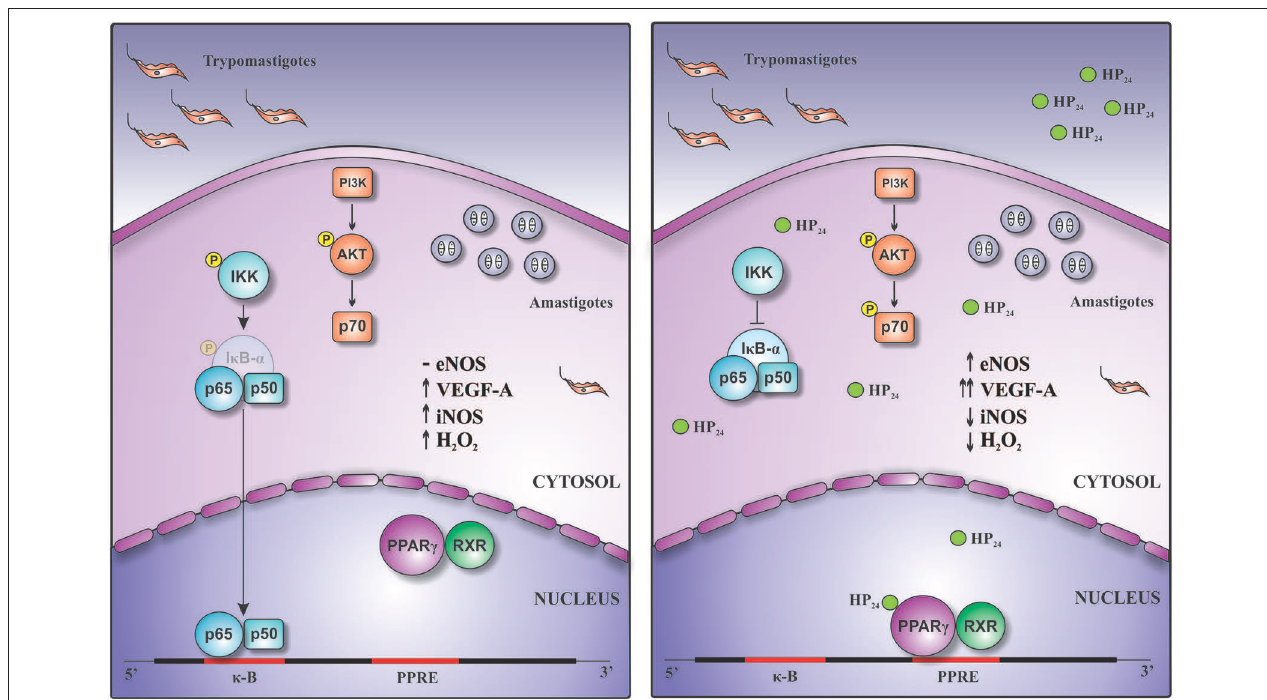
FIGURE 9 | Schematic representation of the pro-angiogenic and anti-inflammatory actions of HP 24 in T. cruzi -infected macrophages. Treatment of T. cruzi -infected macrophages with HP 24 exerts pro-angiogenic effects, increasing the expression of eNOS and of VEGF-A. This effect depends on both PPAR γ and PI3K/AKT/mTOR pathways. Besides, HP 24 avoids activation of NF- κ B, thereby preventing iNOS expression, NO release, and H 2 O 2 production. This anti-inflammatory effect occurs in a PPAR γ -dependent manner.